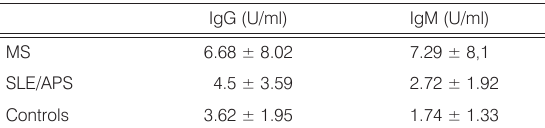
Table 1. Levels of AnV in patients with multiple sclerosis, in systemic lupus erythematosus and controls.